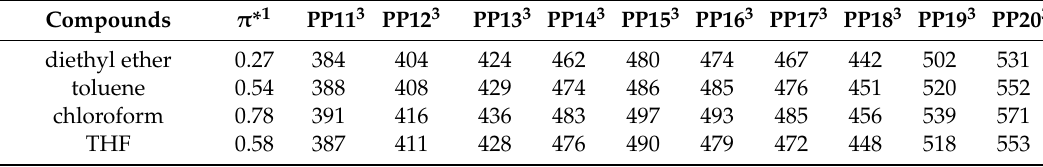
Table 4. Summary of the optical properties of PP11–PP20 in twenty-three solvents and Kamlet and Taft parameters π